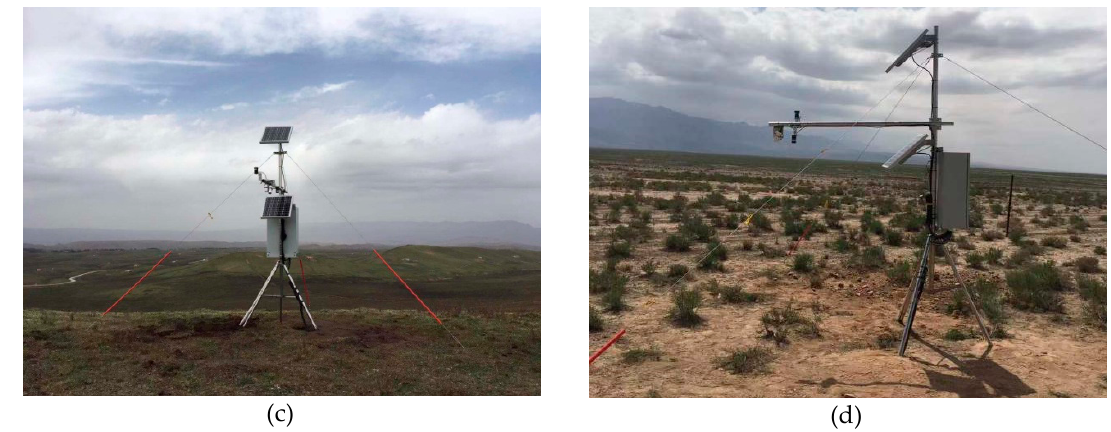
Figure 1 . Overview of observation stations and emissivity observation instrument 102F, where ( a ) is the Dingxi station, ( b ) is the emissivity observation instrument 102f, ( c ) is the Kangle station, and ( d ) is the Qifeng station.